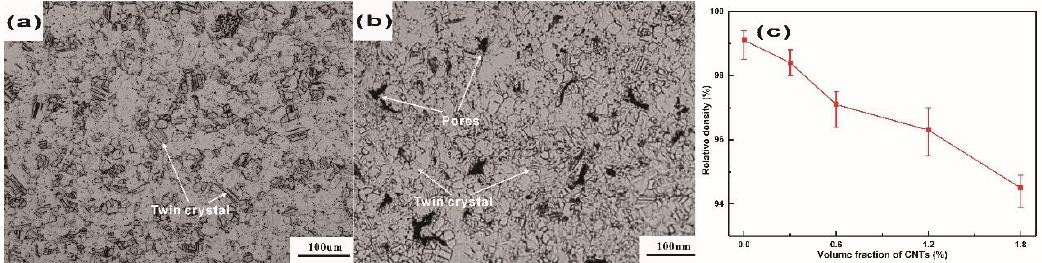
Figure 3. Typical metallographs of ( a ) pure Cu and ( b ) Cu / 0.6 CNTs and ( c ) relative density of Cu / CNT composite.